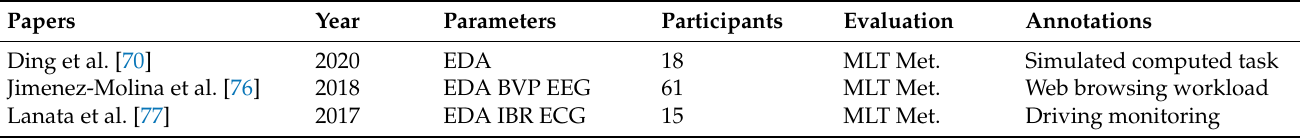
Table 9. Physiological signals used for mental/cognitive workload